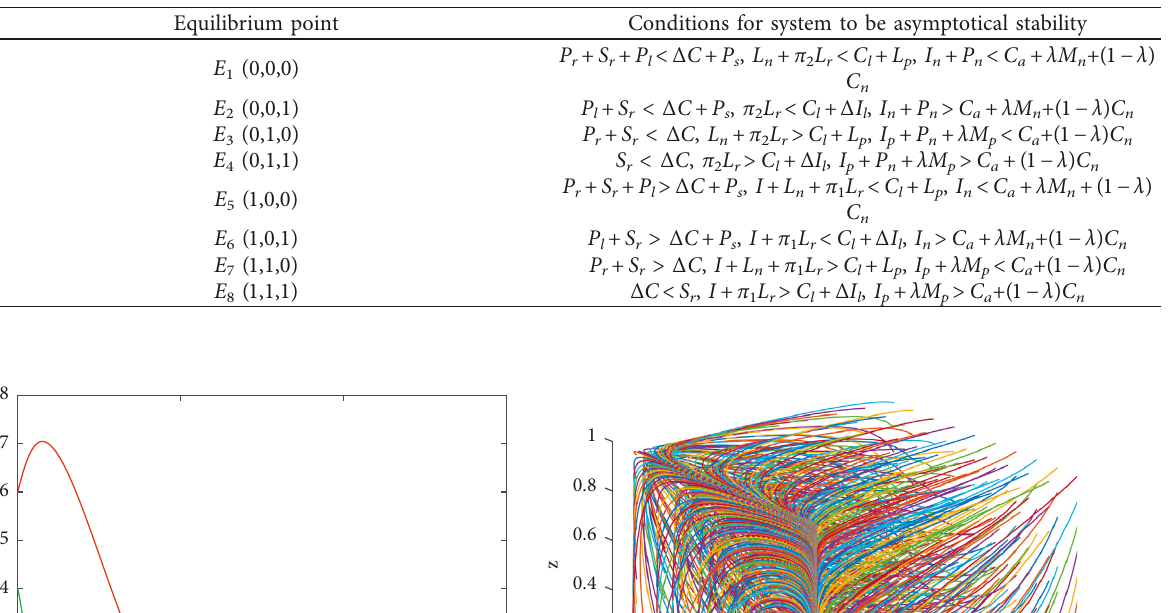
Table 4: Conditions for system to be asymptotical stability at each equilibrium point.